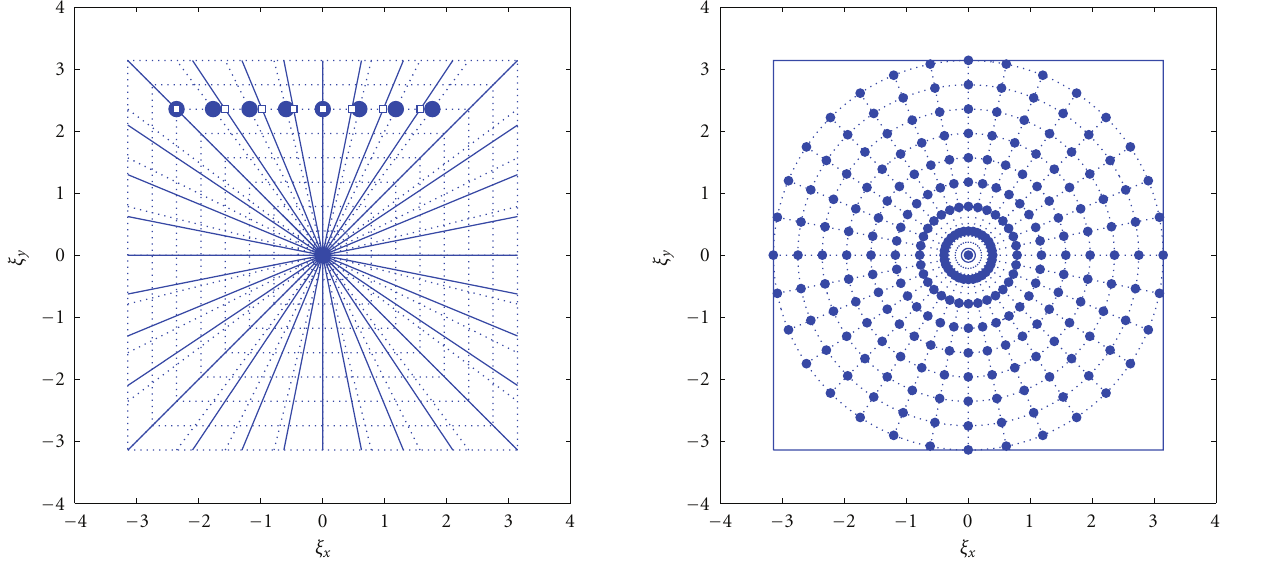
Figure 3: Rotate the rays interpolation stage. Circles denote the known pseudo-Polar grid points while the squares are the destina- tion equiangular spaced rays. (This figure first appeared in [33]).